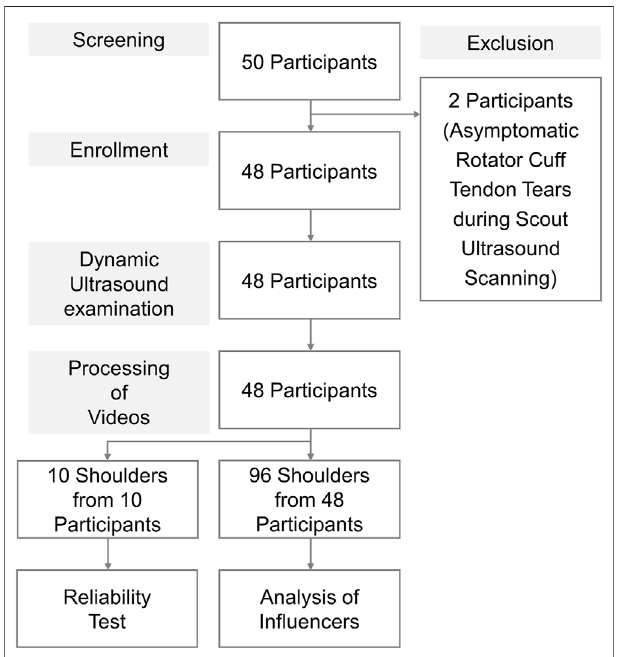
FIGURE 3 | Flow diagram of participant